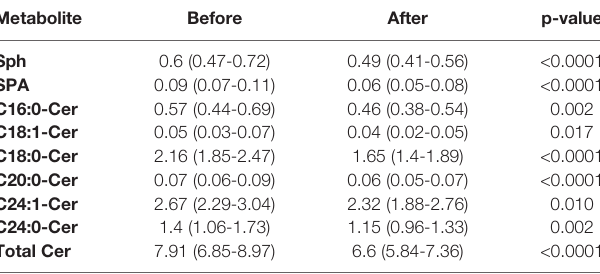
Presented are mean values with 95% con fi dence intervals